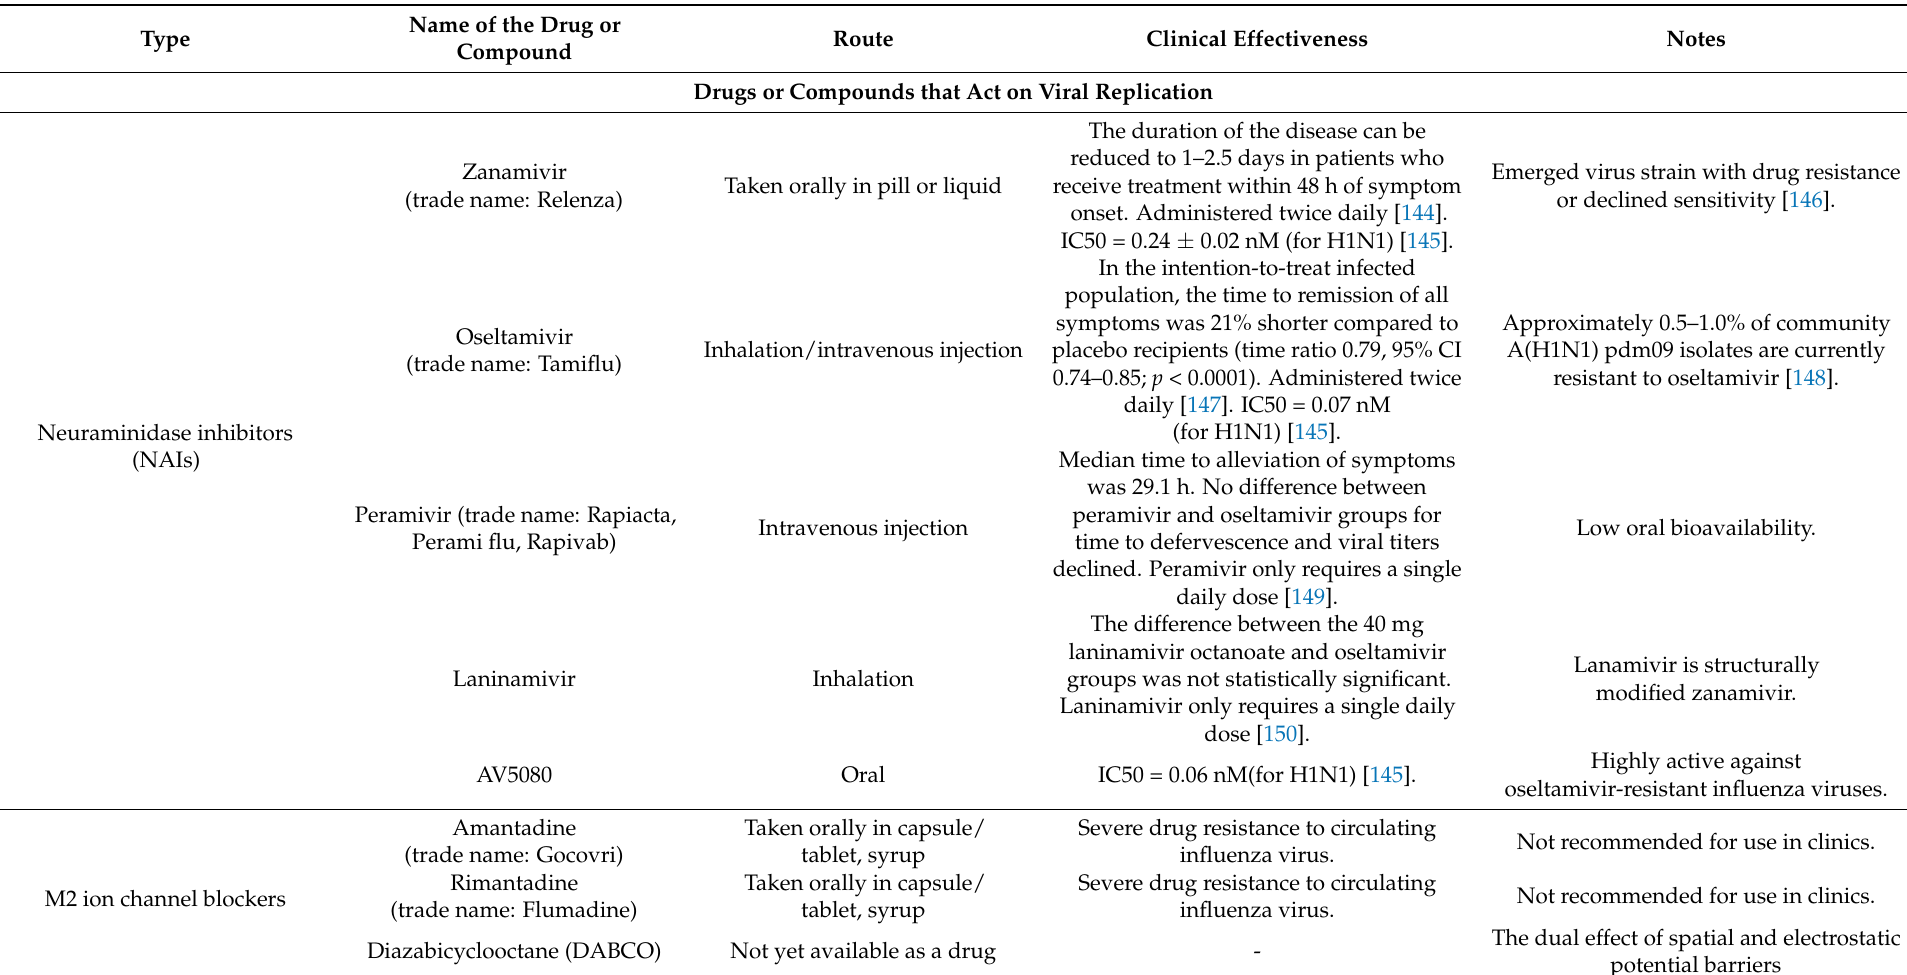
Table 5. Characteristics of anti-influenza virus drugs or